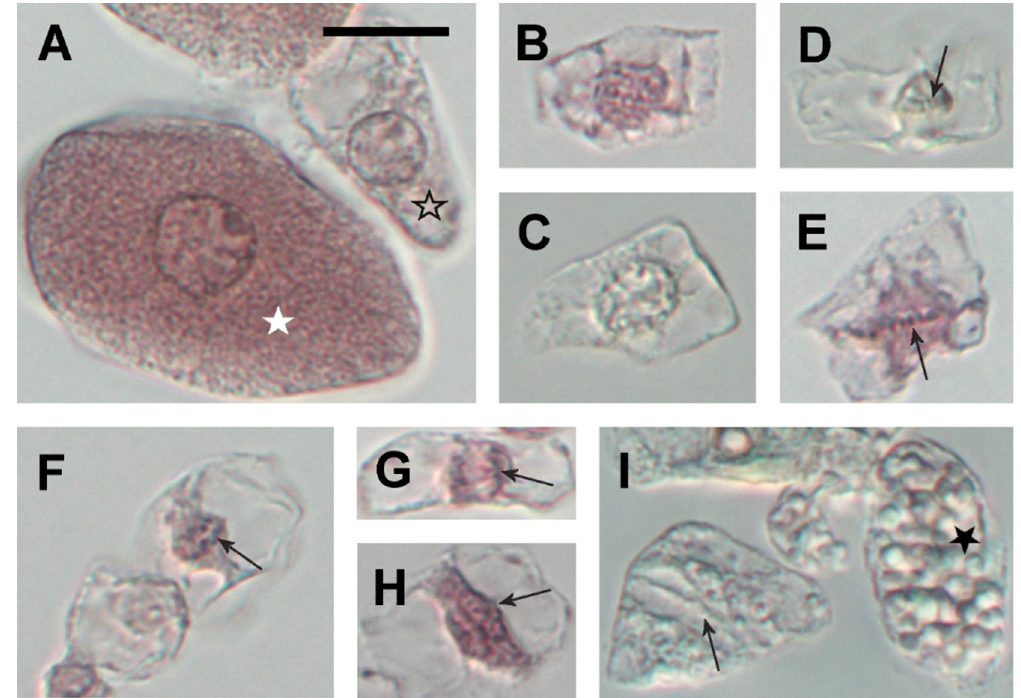
Figure 6. Cell types separated from L. japonicus root nodules after maceration in pectinase. Infected cell (white star) and noninfected interphase cell (open star) ( A ). Early and late prophase cells, respectively ( B , C ). Metaphase cells (arrows point to the metaphase plate) ( D , E ). Anaphase cell (arrow points to one group of chromatids) ( F ). Early and late telophase cell (arrows point to one of the twin nuclei) ( G , H , respectively). Cell in cytokinesis (arrow points to the cell plate) and noninfected fully differentiated cell with large starch grains (black star) ( I ). Images ( A , B , E – H ): cells stained with cold acetocarmine, images ( C , D , I ): unstained. All images are in the same magnification, bar = 20 µm.